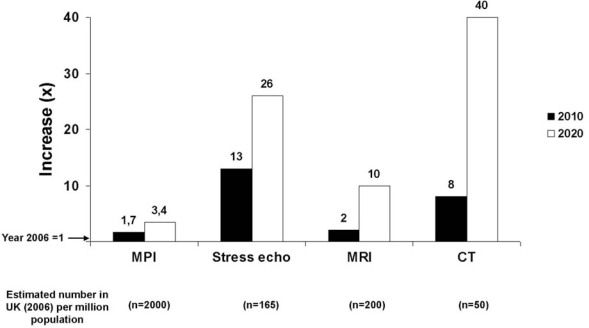
Future trends in the use of cardiac imaging up to the year 2020. Redrawn from the original data of reference [35].